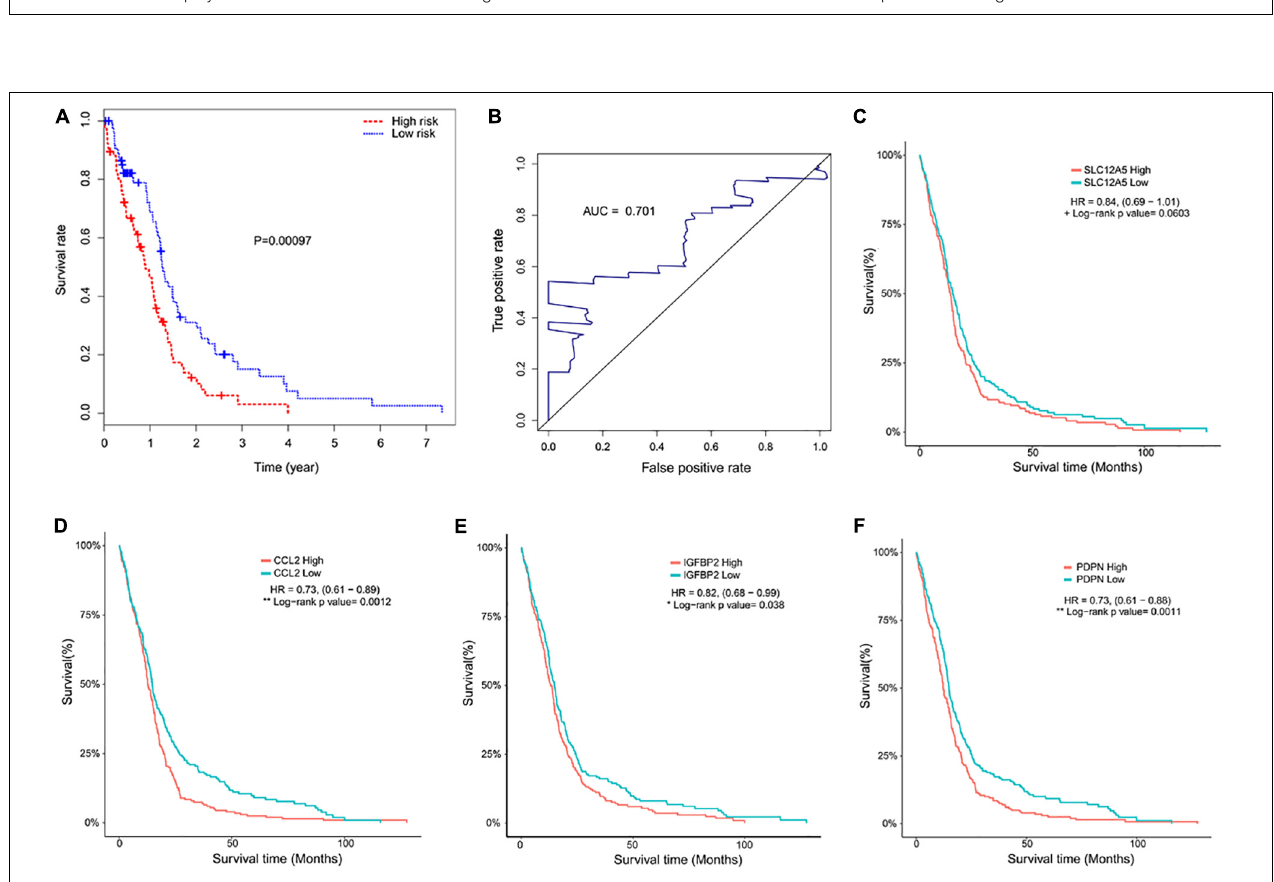
FIGURE 5 | Cox proportional hazards regression model. Purple depths of the third column reveal the risk score of the low-risk and high-risk groups. Green depths of the fourth column display the survival status and time of 152 glioblastomas. The lowest column shows the heatmap of the model genes.